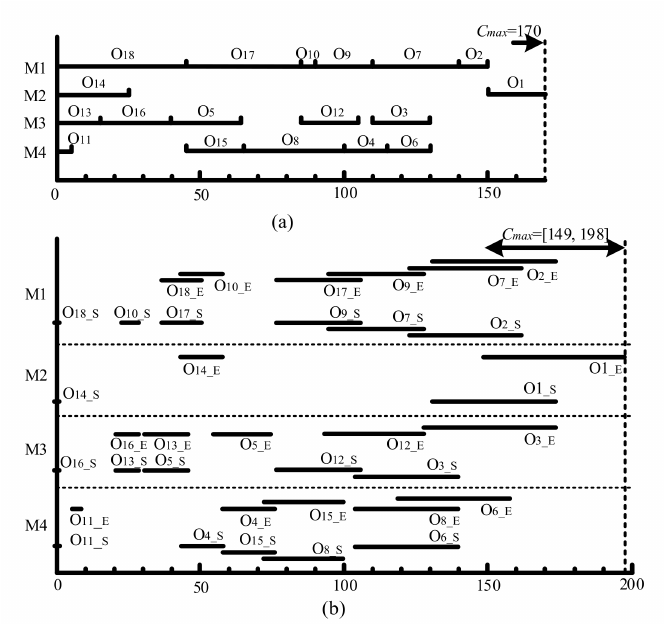
Figure 6. Gantt chart of the optimal solution for Case 1. ( a ) Optimal solution on deterministic scenario; ( b ) Optimal solution on uncertain scenario with 80% confidence